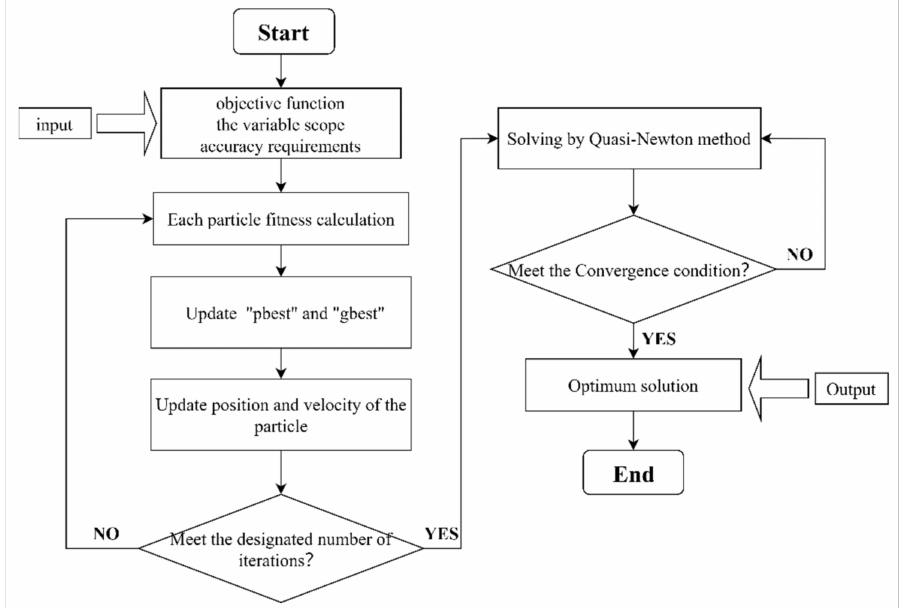
Figure 2. Flow chart of the PSO–QNMs hybrid